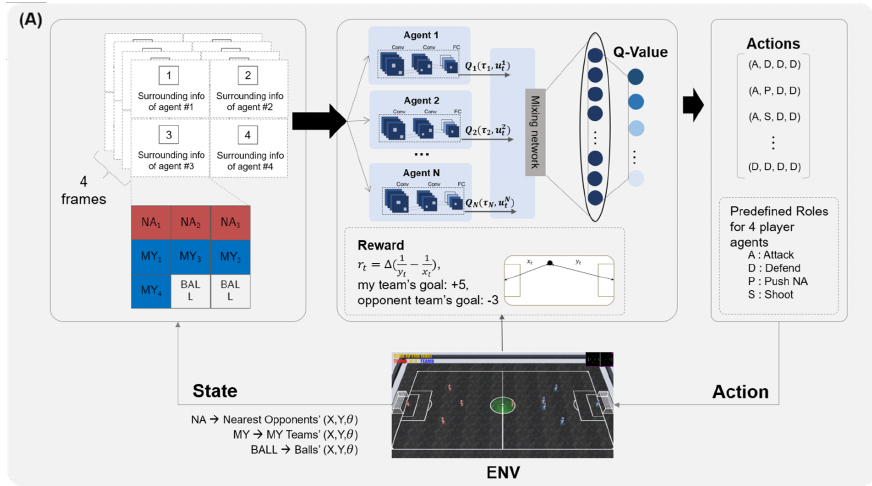
Figure 7. An overview of the artificial football team using QMIX